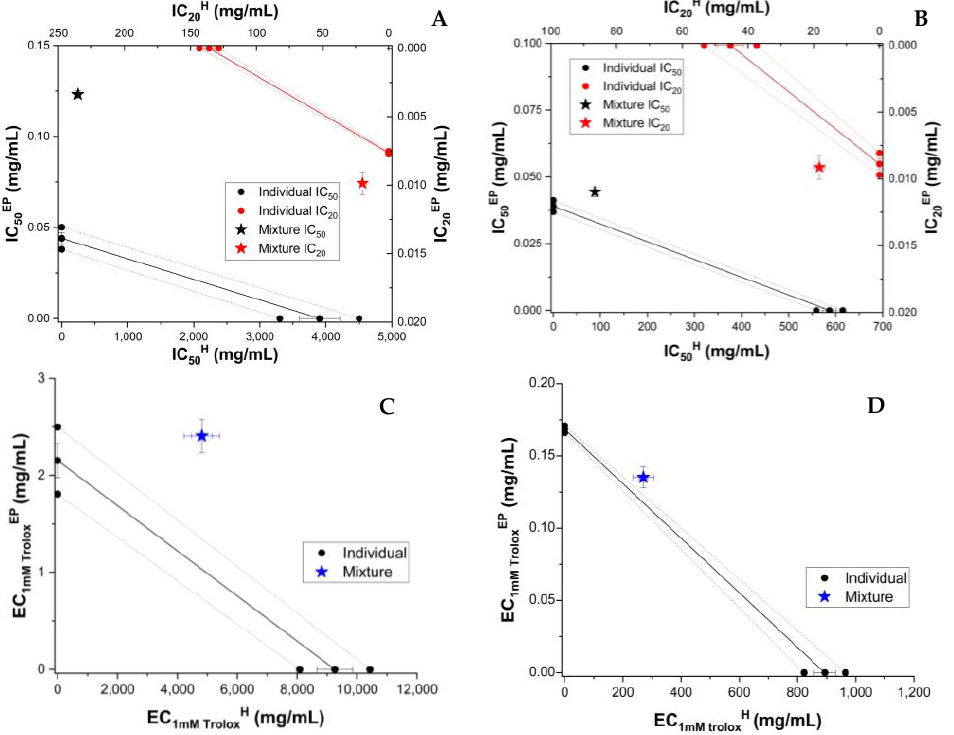
Figure 3. Isobolograms of honey (H) and epicatechin (EP) based on IC 50 (half-maximal inhibitory concentration) and IC 20 (inhibitory concentration at 20% substrate inhibition) for DPPH ( A ) and ABTS ( B ) methods, and based on EC 1mM Trolox (effective concentration at 1 mM Trolox equivalent of the samples) for CUPRAC ( C ) and FRAP ( D ) methods. The error bars from three measurements are shown for each value. Confidence intervals at 95% confidence are shown by dashed